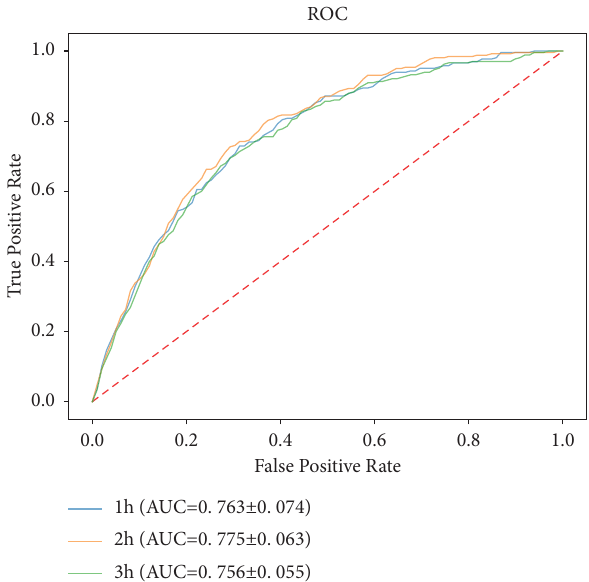
Figure 2: Comparison of the ROC curves of the GRU models in 1h, 2h, and 3 h groups. ROC: receiver operating characteristic curve; AUC: area under the curve; GRU: gated recurrent